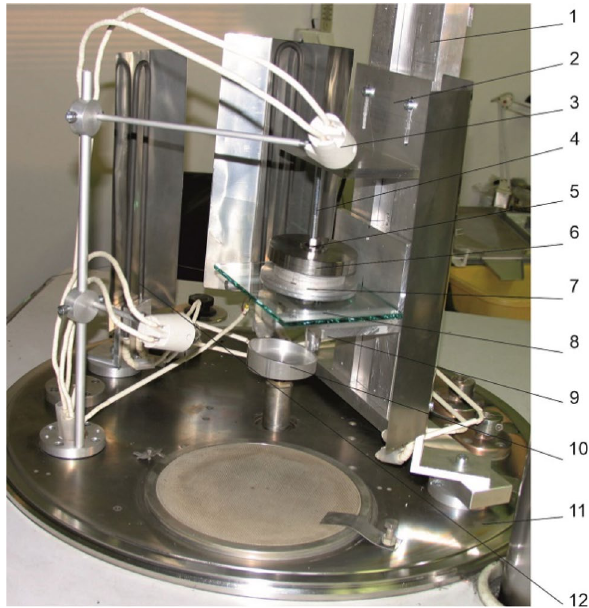
Fig. 8 Experimental device (1—Frame of the device, 2—Fixed ramp, 3—Light, 4—Element hinge, 5—Ball joint, 6—Weight, 7— Gripping element, 8—Glass, 9—Movable support, 10—Cam, 11— Base of the vacuum chamber, 12—Resistance heating